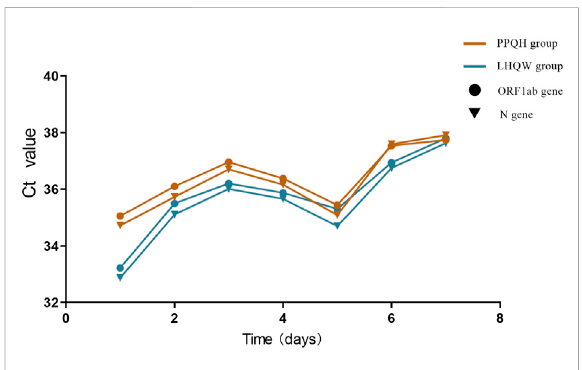
FIGURE 2 ComparisonofCtvaluesofORF1abandNgenebetweenthe two groups of SARS-CoV-2-infected patients.